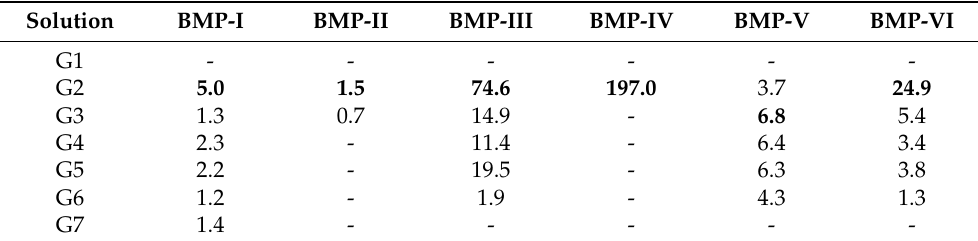
Table 5. Tradeoffs between makespan and OIDT; gain in OIDT [%] by losing 1% of makespan relative to the best makespan solution (G1) obtained by